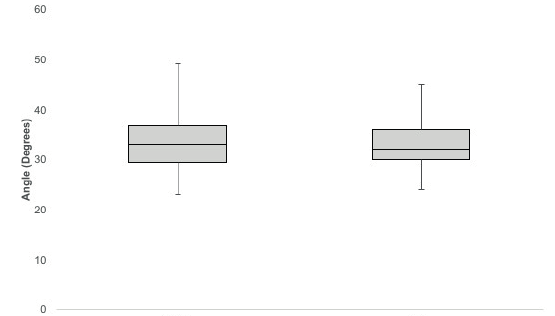
Figure 3. Angle between the optic nerve and the nasal midline. Shown is a box-and-whisker plot for the right and left side measurement points. Total sides for each measurement point, N = 50. All measurements reported in